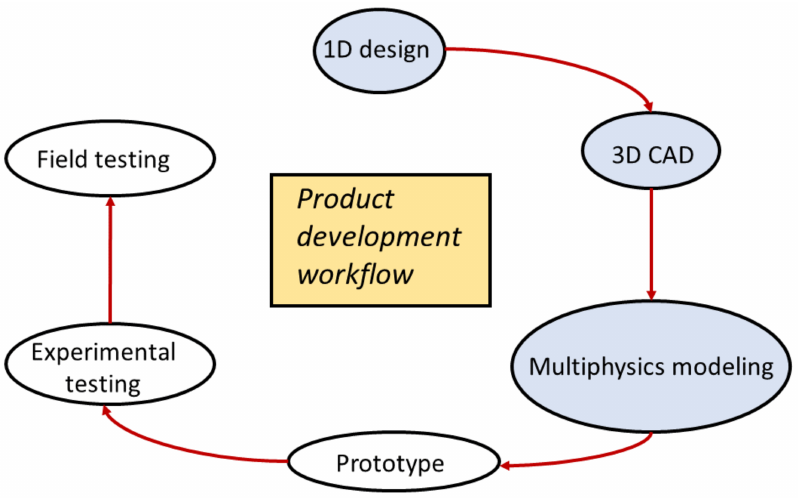
Figure 12. Product development workflow, including multi-physics